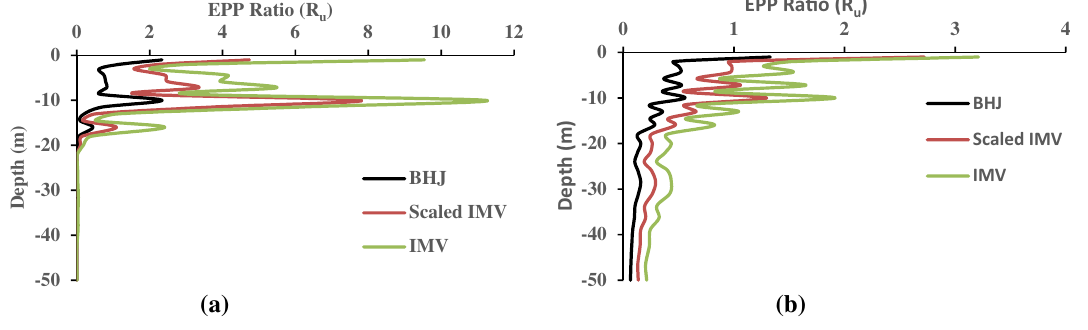
Fig. 8 Profile of R in NKD soil a near field and b far field for various input motions u